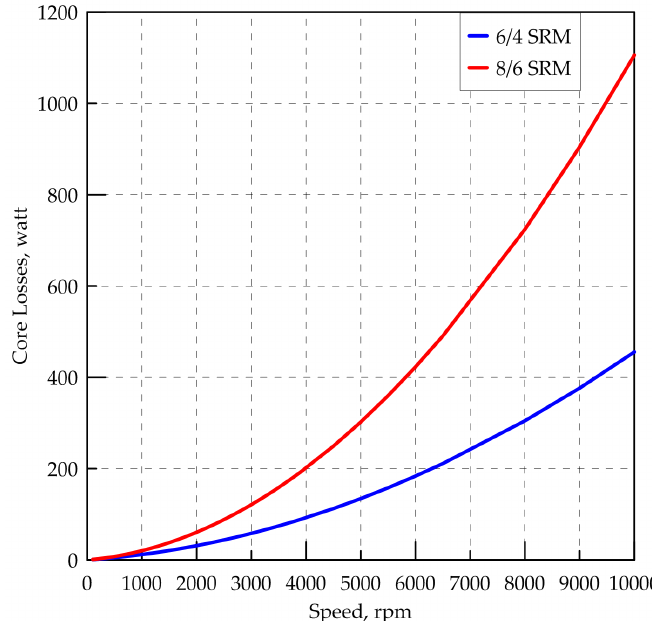
Figure 11. Core losses of selected optimal designs A1 (8/6 SRM) and B1 (6/4 SRM) at different speeds.